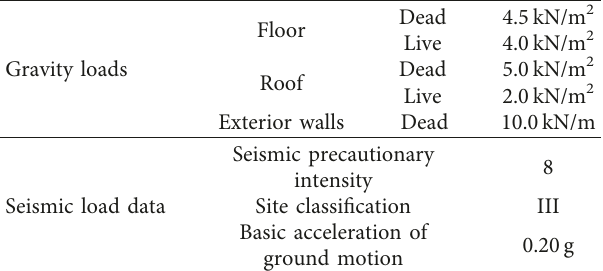
Figure 6: Elevation view of 9-story prototype buildings: (a) SC-TOBFs and (b) BRBFs. Table 1: Load